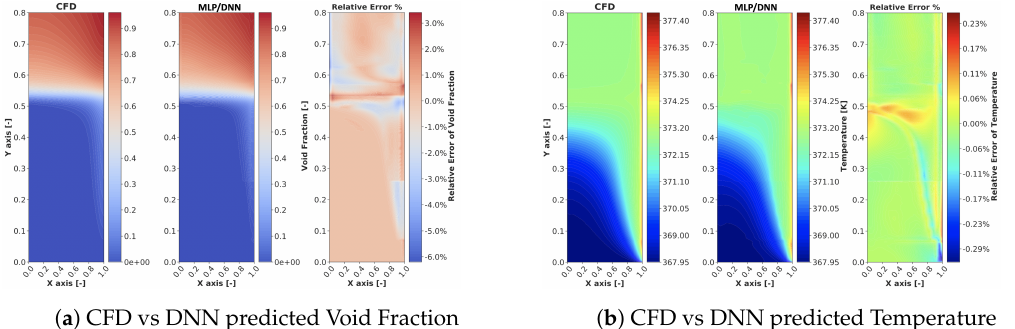
Figure A5. Interpolation dataset: Void fraction and temperature field of CFD and predicted by the DNN/MLP model and the relative error for an interpolation dataset at q (cid:48)(cid:48) = 14,000 W/m 2 , u = 0.05 ms − 1 is presented. The plot above presents the predictive nature of the DNN model to predict the full flow field of the mininchannel. It can be seen that the DNN model is capable of reproducing the void fraction field with a miximum relative error of − 6%. It can be further noted that the error increases as the void fraction increases in the mininchannel. Temperature field using the DNN model is presented in Figure A5b. Compared to the void fraction prediction the DNN model has better performance when predicting the temperature field with a maximum relative error of